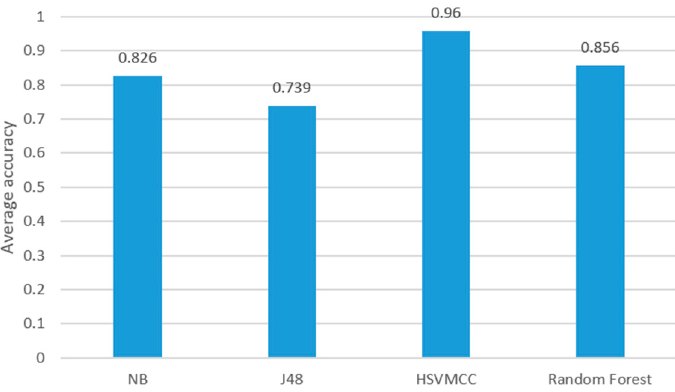
Figure 9. The comparison of average accuracy of the proposed AR system vs. other classifications.